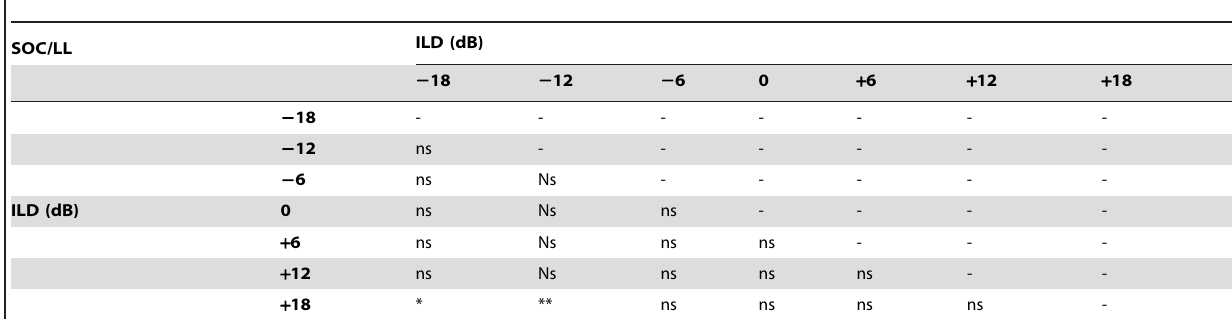
P-value table computed from the BOLD signal ratios measured from a group of voxels bordering the superior olivary complex and lateral lemniscus (SOC/LL) of all animals. Statistical analysis was performed using one-way repeated measures analysis of variance and Tukey’s test. The symbols ns, *, and ** indicate p . 0.05, p , 0.05, and p , 0.01, respectively. The ratios measured at 2 12dB and 2 18dB ILD are statistically significantly greater than those measured at + 18dB ILD (p , 0.05).